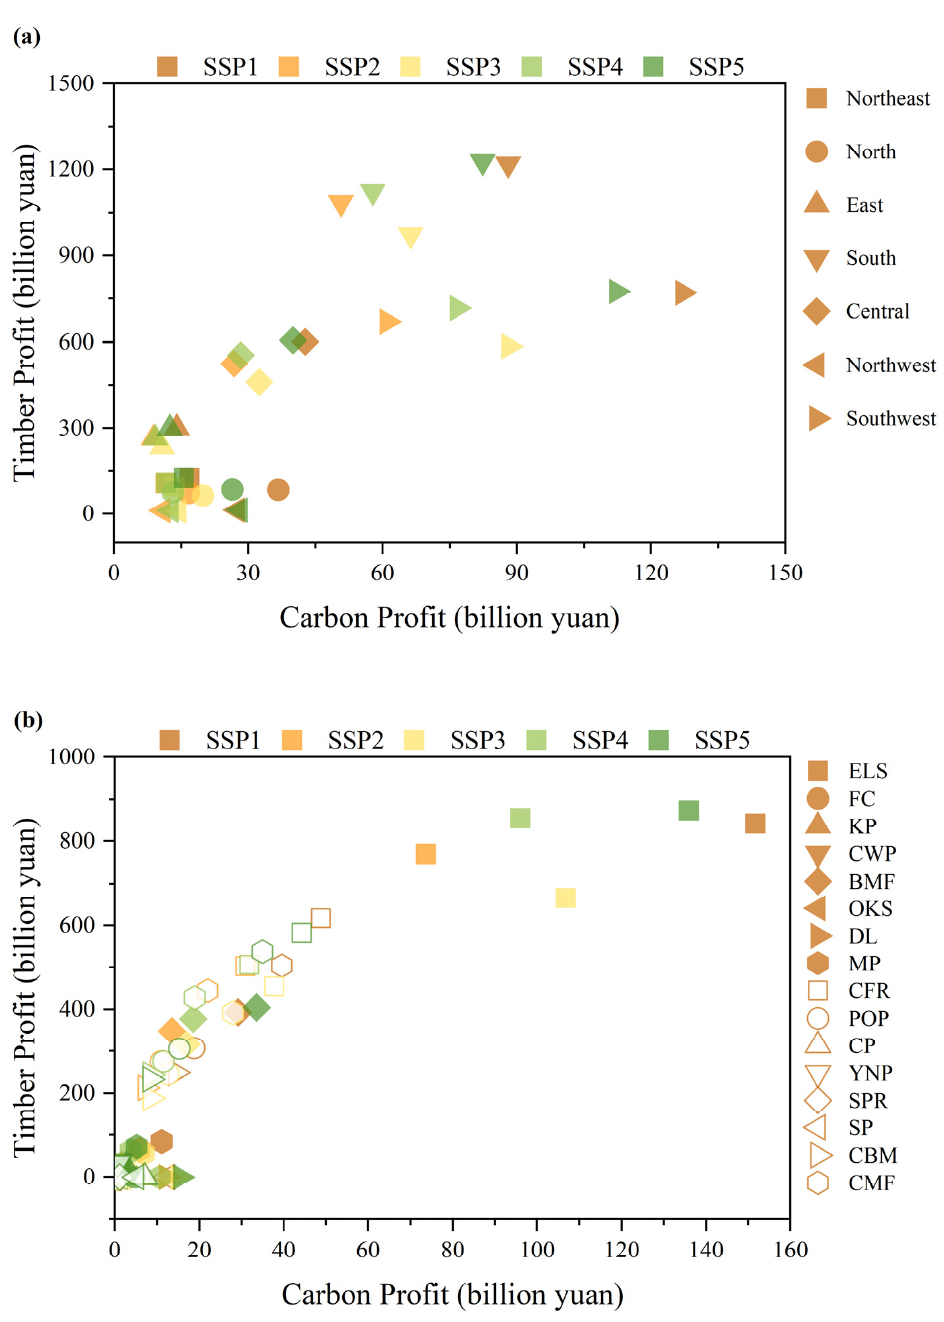
Figure 4. Relationship between timber yields and carbon sequestration by regions ( a ) and by tree species ( b ) under all species ( b ) under all SSPs.